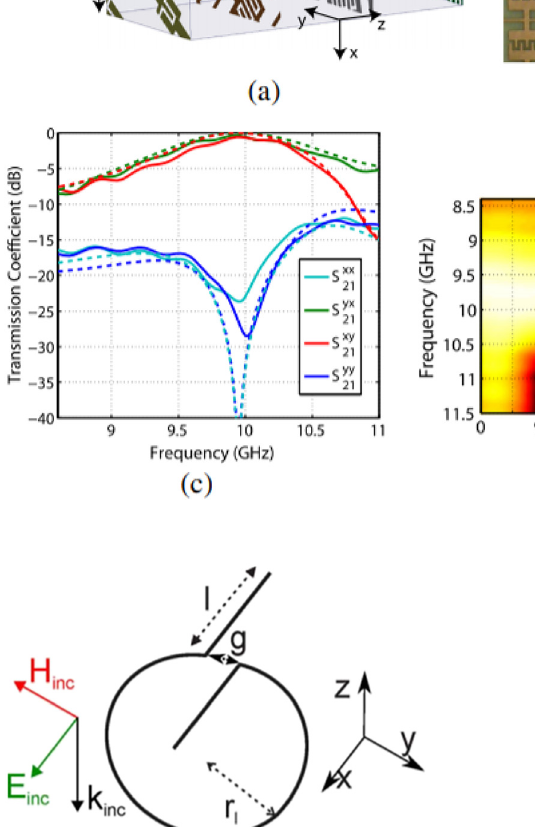
Figure 13: (Reprinted with permission from Ref. [15]). Metasurface exhibiting polarization rotation near 10 GHz.